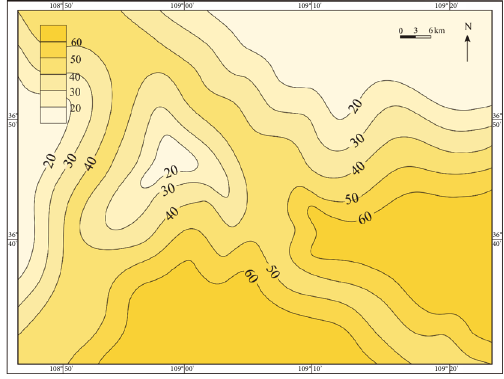
Figure 10: Distribution map of SO 42 − × 100/Cl − ratios; the contour line represents speci fi c numerical values.